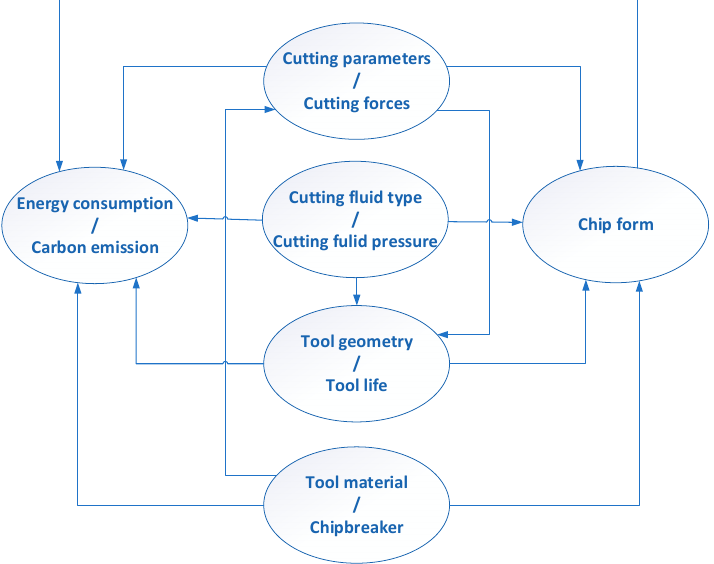
Figure 4. Influence and interdependence of cutting parameters on current consumption and chip geometry.